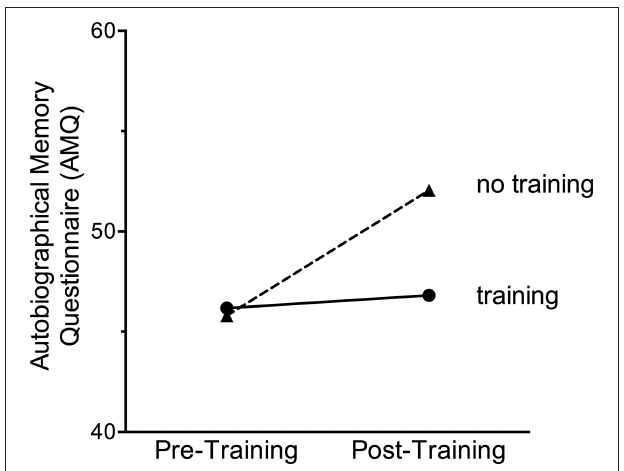
FIGURE 4 | The strength of an autobiographical memory of a very stressful event did not change after any of the training sessions (MAP Training, meditation or exercise alone). However, the strength of the personal stressful memory was enhanced in women who did not participate in any training procedures.